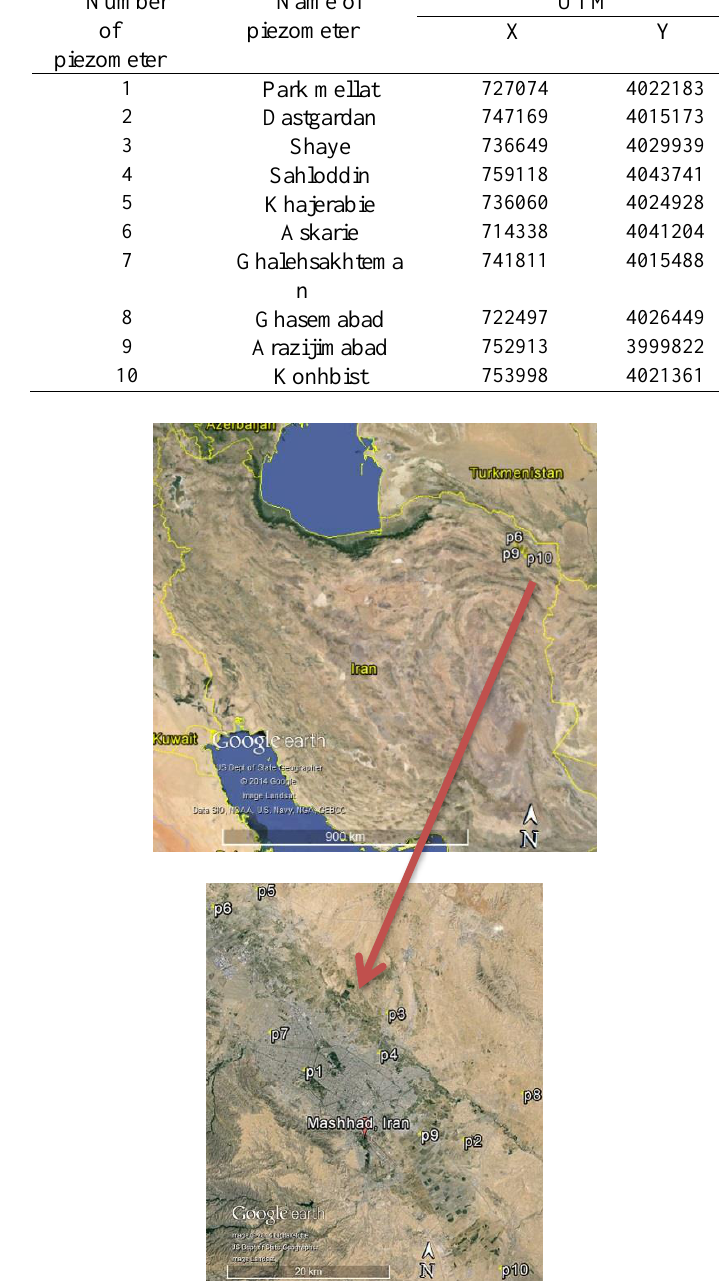
Fig . 1 Location of piezometers in Iran and the study